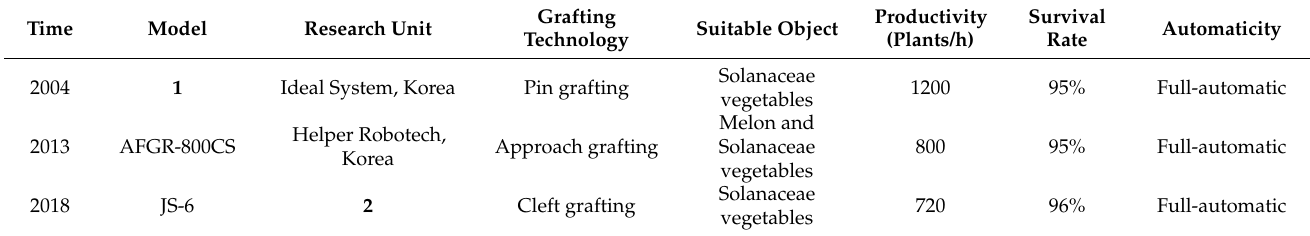
Figure 7. AFGR-800CS supreme precision grafting robot developed by Helper Robotech. Table 4. Comparison of the Characteristics of Other Vegetable Grafting